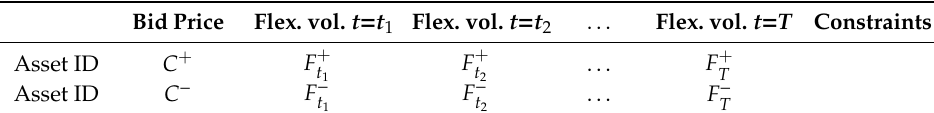
Table 4. Bids for iteration 1 .